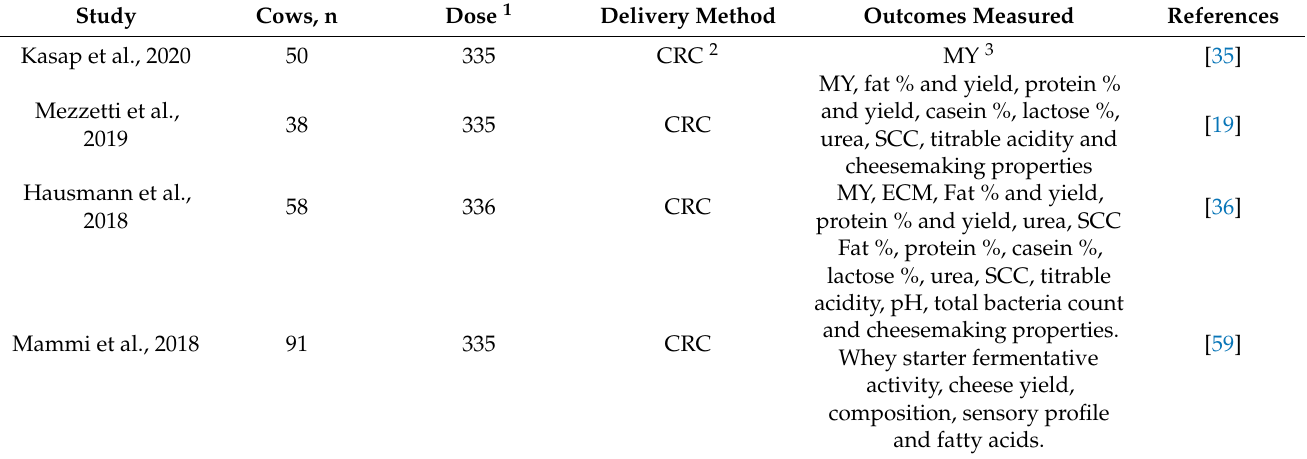
Table 3. Studies included in this review evaluating the effect of monensin during transition period on production